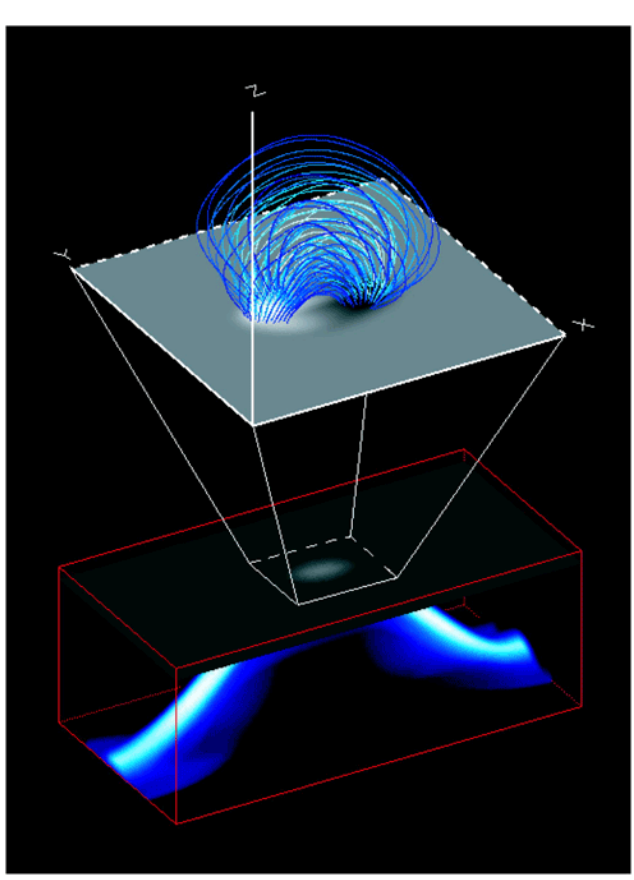
Figure 61: 3D rendering illustrating the one-way coupled model of flux emergence by Abbett and Fisher (2003). MHD quantities from anelastic simulations of the rise of Ω-loops in the convection zone are used to drive the bottom boundary of a compressible MHD code. Image reproduced with permission, copyright by